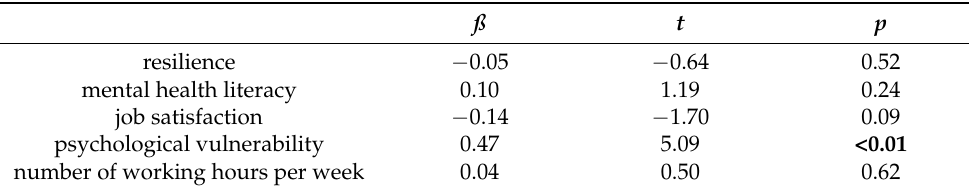
Table 4. Influence of the potential protective and vulnerability factors on municipal workers’ stress